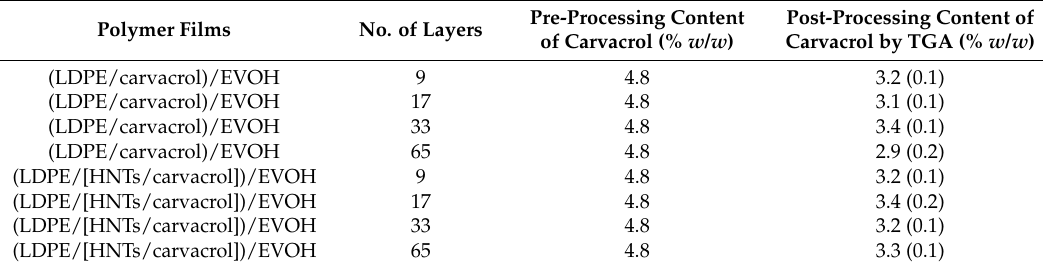
Table 2. Carvacrol content in the different films as measured by Thermal Gravimetric Analysis (TGA) (the number in parenthesis indicate the standard deviation obtained from at least three independent experiments).